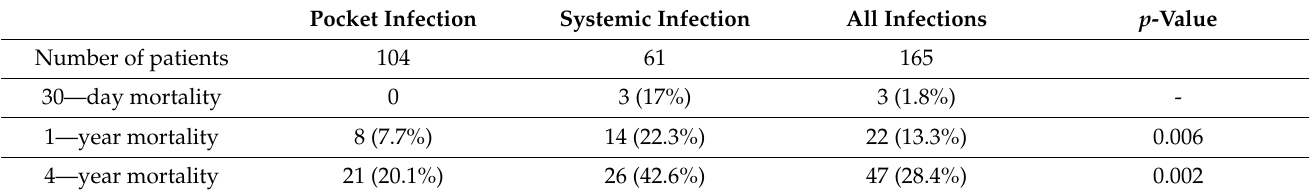
Table 5. Long-term mortality for patients who underwent an extraction due to CIED infection.